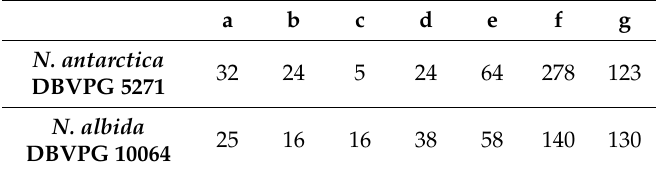
Table 3. Number of DNA methylation changes of N. antarctica DBVPG 5271 and N. albida DBVPG 10064 under cold stress condition with definition of arbitrary classes.